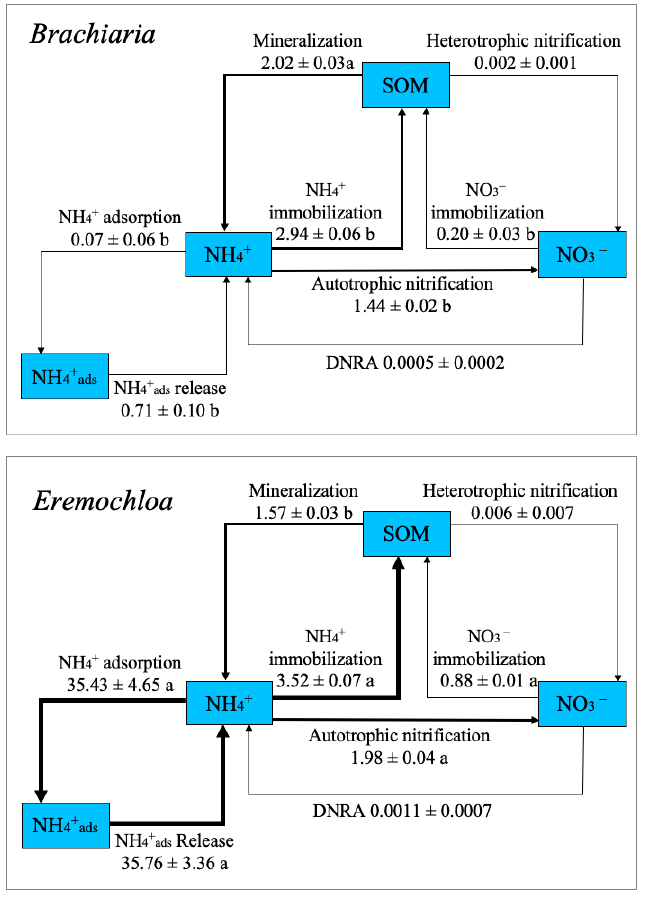
Figure 3. Nitrogen cycles in the Brachiaria and Eremochloa soil. Values shown represent gross N transformation rates (mean ± SD, µ g N g − 1 d − 1 ). The thickness of the arrows indicates the strength of each process. Different lowercase indicates denote a significant difference between treatments at p < 0.05. NH 4+ads : ammonium adsorbed to soil. Autotrophic nitrification was a dominant NO 3 − production process in both sets of soils, while heterotrophic nitrification was negligible. Brachiaria planting reduced the autotrophic nitrification rate to 1.44 μ g N g − 1 soil d − 1 from 1.98 μ g N g − 1 soil d − 1 in the Eremochloa soil. The Brachiaria soil also showed a lower nitrification capacity (ONH 4+ /M) than the Eremochloa soil (71.3 vs. 126.0%, respectively). Immobilization of NO 3 − overwhelmingly surpassed the rate of dissimilatory nitrate reduction to ammonium